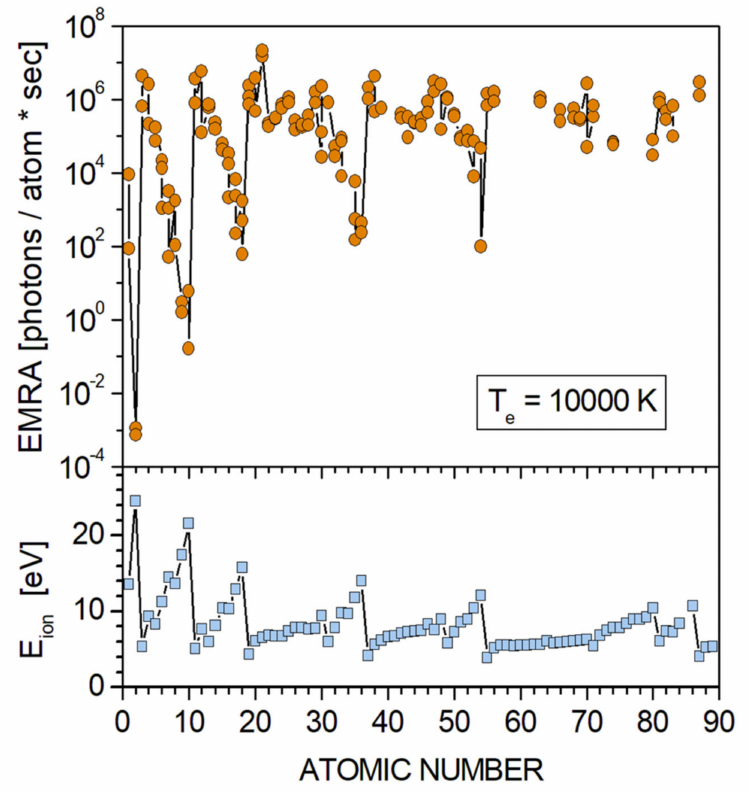
Figure 1. Number of photons emitted per atom and second for optically thin and homogeneous LTE plasma at temperature T e = 10,000 K. This emission rate of atoms EMRA is calculated for most chemical elements using the most intense emission lines of neutral species (upper part). The ionization energy of neutral atoms versus the atomic number of elements (lower part). The sign “*” stands for